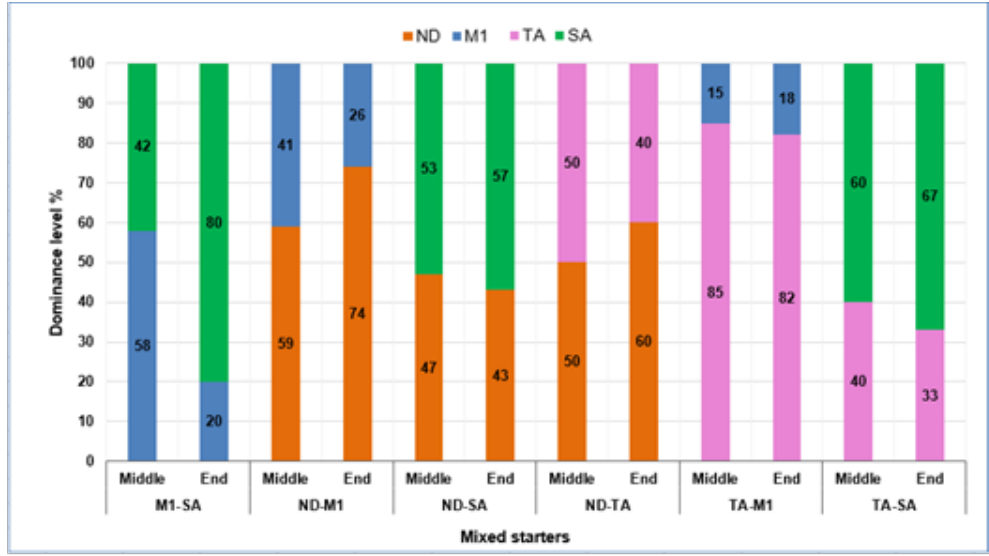
Figure 2. Dominance percentage of strains included in mixed starters during laboratory-scale fermentation in the middle and final phases of the process. For each mixed fermentation and process phase (middle and end), the dominance percentage of each of the two strains composing the mixed starter is reported (i.e., for M1-SA mixed fermentation, the dominance percentage of M1 and SA strains is reported). Middle = fermentation stage with the reduction of 50% of the sugars. Data are mean of two independent experiments.